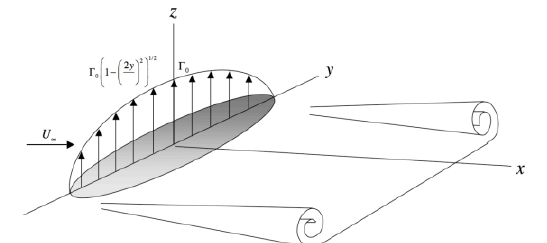
Figure 2: Elliptic lift distribution across hydrofoil span, after [6]